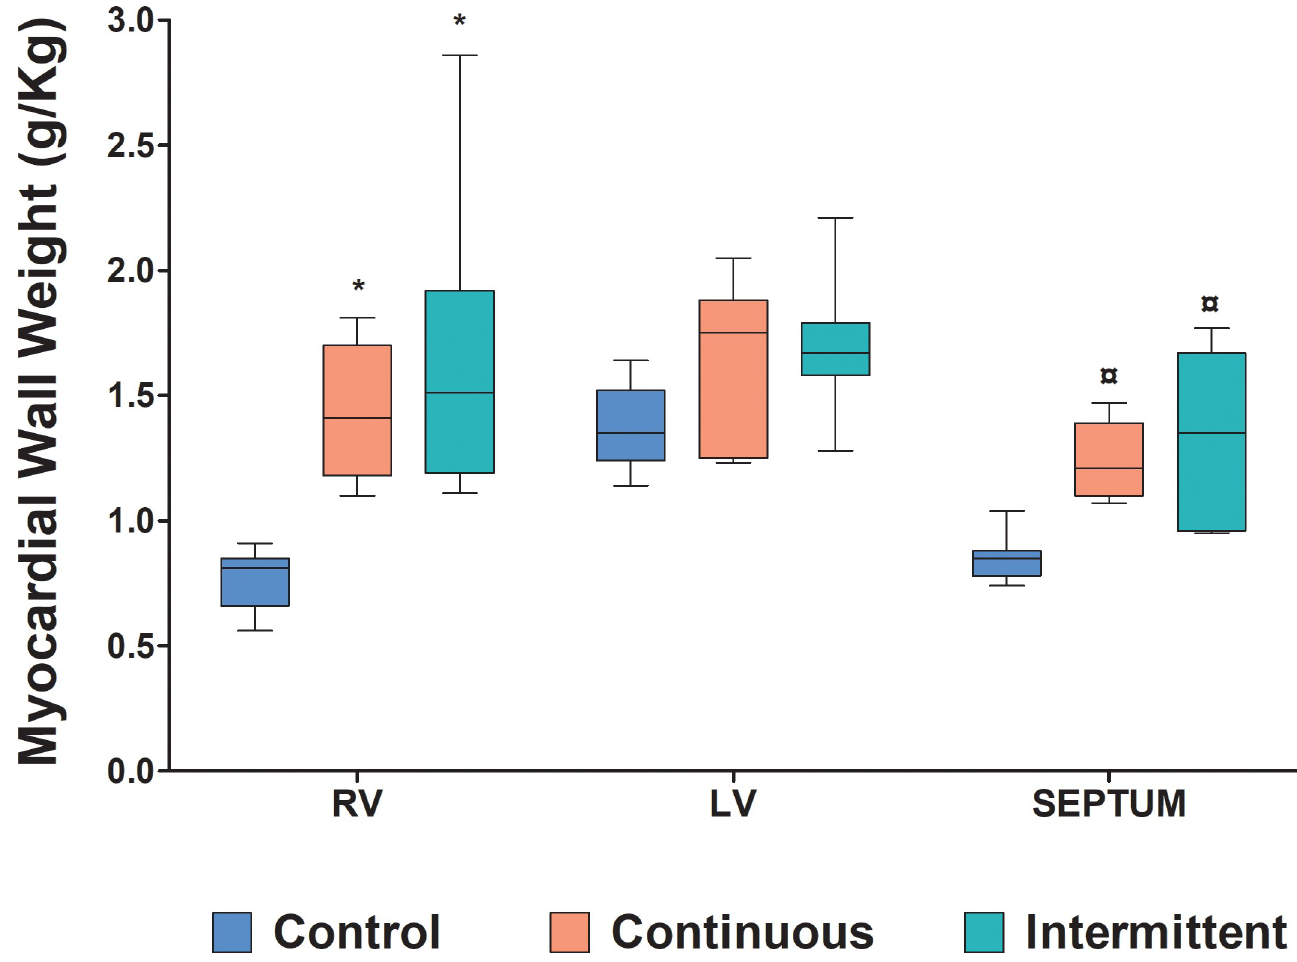
Fig 3. Weights for the right ventricle (RV), left ventricle (LV), and septum indexed to body weights of the 3 groups. � p < 0.001 when compared to the control group; ¤ p < 0.047 when compared to the control group. n = 7 in each group.